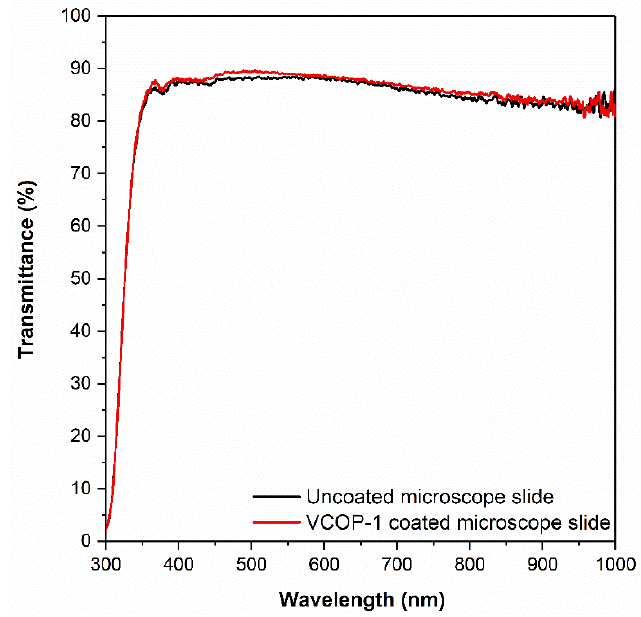
Figure 17. Measured optical transmittance of uncoated and VCOP-1 coated glass substrates.